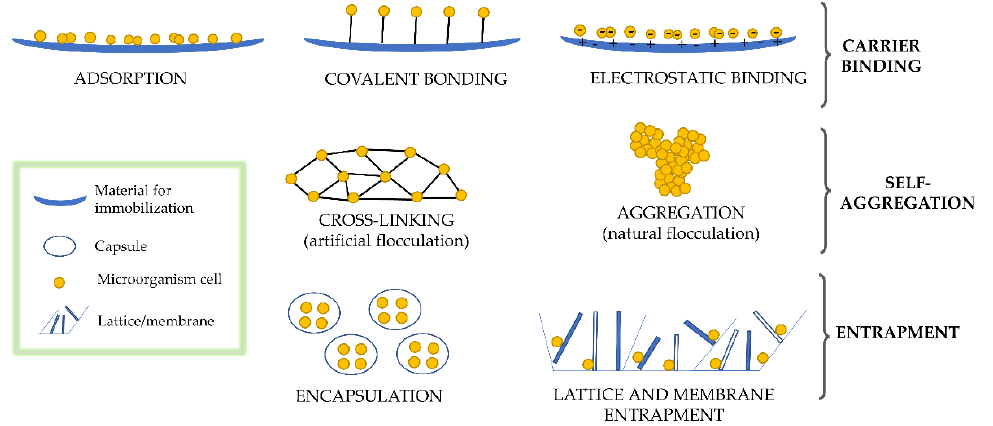
Figure 2. Methods of microorganisms’ cells immobilization.